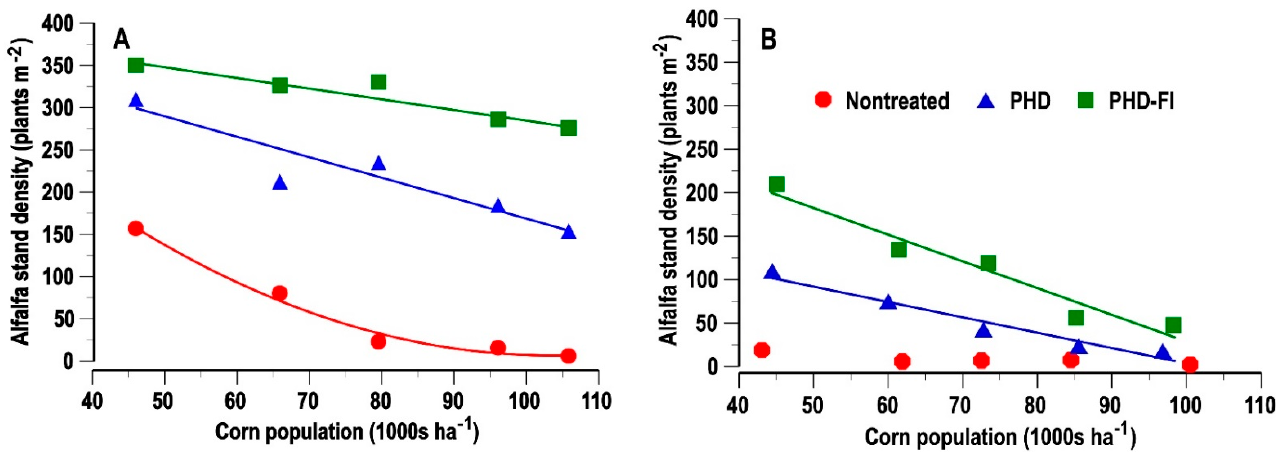
Figure 5. Photographs of interseeded alfalfa taken at the time of defoliation and leaf necrosis ratings on 19 July 2017 ( A – C ) and 2 August 2017 ( D – F ). Agrichemical treatments consisted of a nontreated control ( A , D ), prohexadione ( B , E ), and prohexadione, followed by fungicide and insecticide ( C , F ). Corn population was approximately 79,000 plants ha − 1 at harvest in 2017.